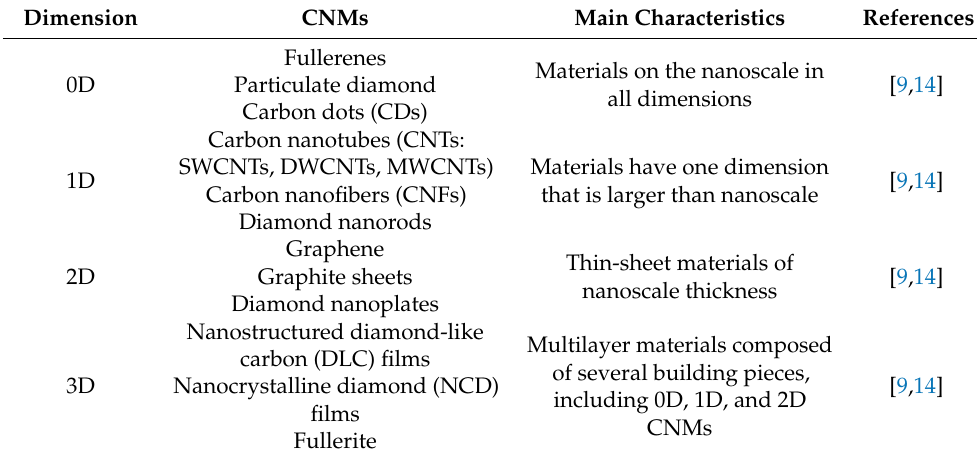
Table 1. Classification and main characteristics of